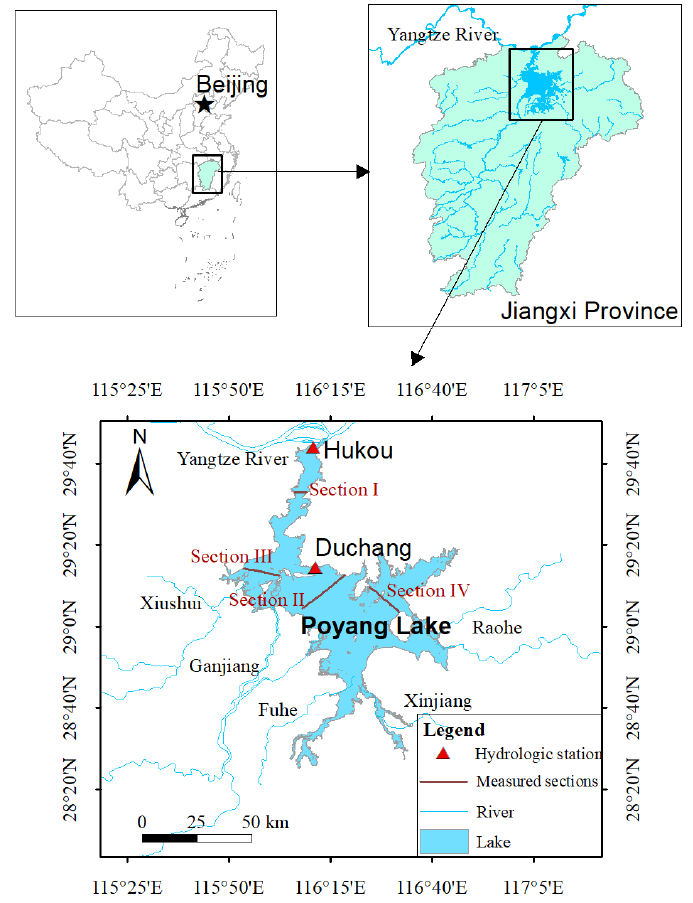
Figure 1. Location of the Poyang Lake, China: The red triangle represents the hydrologic stations. The blue area is Poyang Lake. The blue line represents the river, and the red lines are the four topographic monitoring sections of the lake.